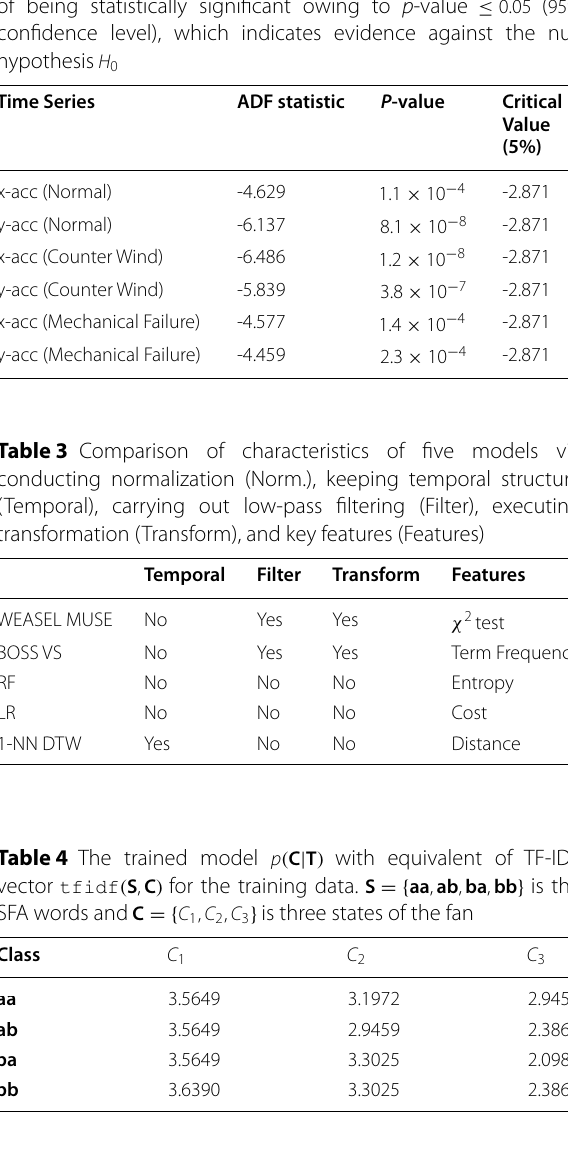
Table 2 Augmented Dickey‑Fuller (ADF) Test Results: The results show that all of six time‑series are found to be stationary of being statistically significant owing to p ‑value ≤ 0.05 ( 95% confidence level), which indicates evidence against the null